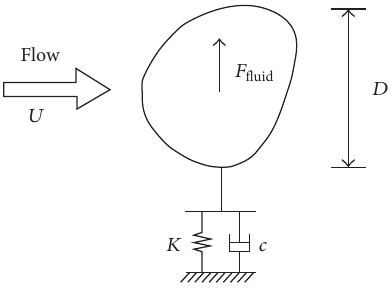
Figure 1: Sketch of flow induced motion of the cylinder in the transverse